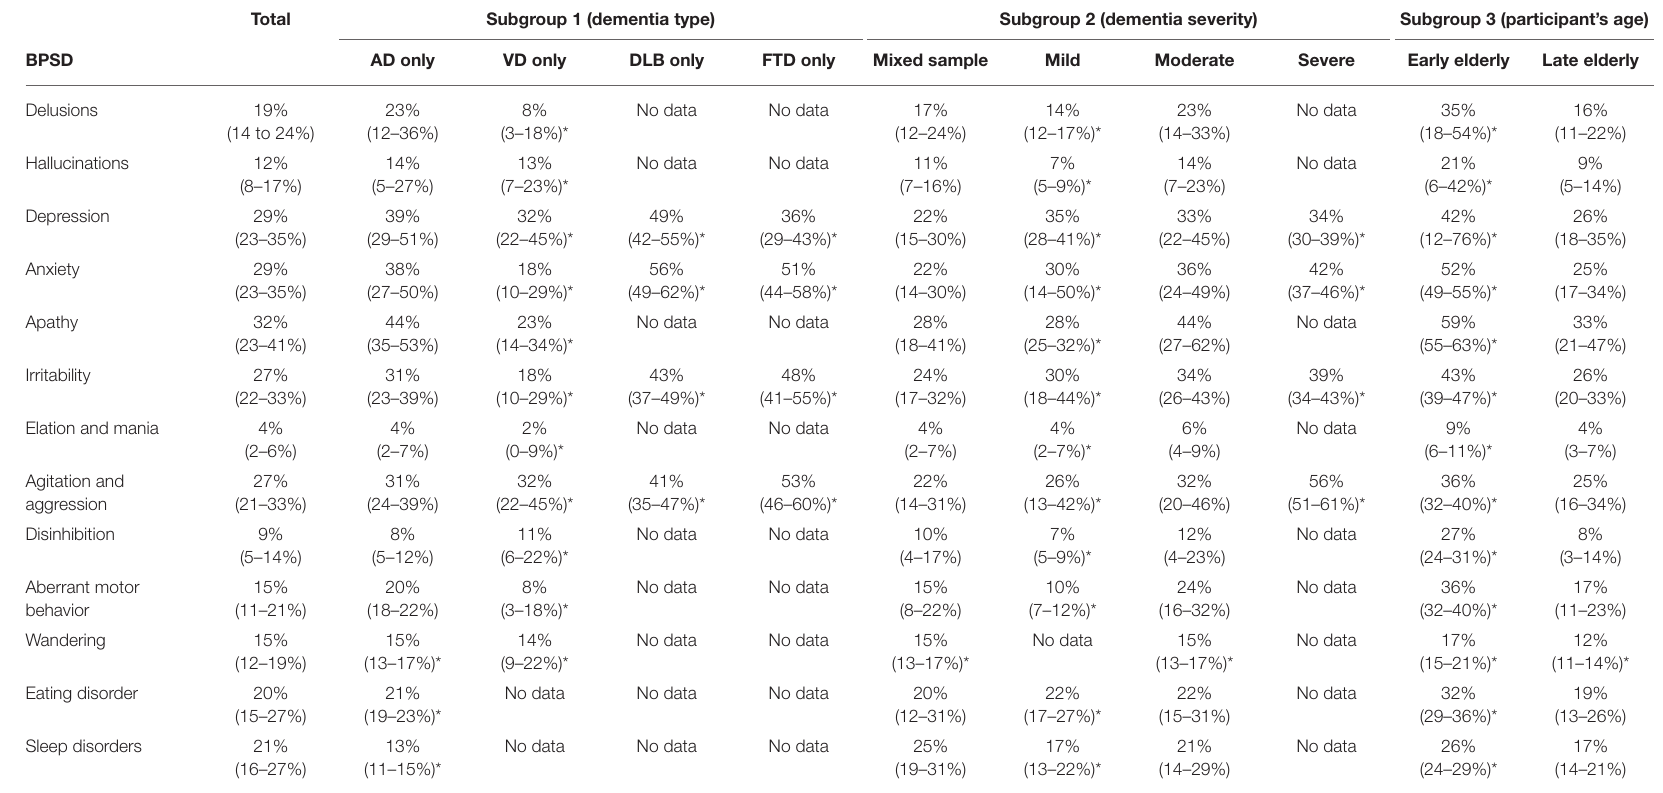
TABLE 4 | Subgroup analysis of estimated prevalence of BPSD symptoms (mean, 95%